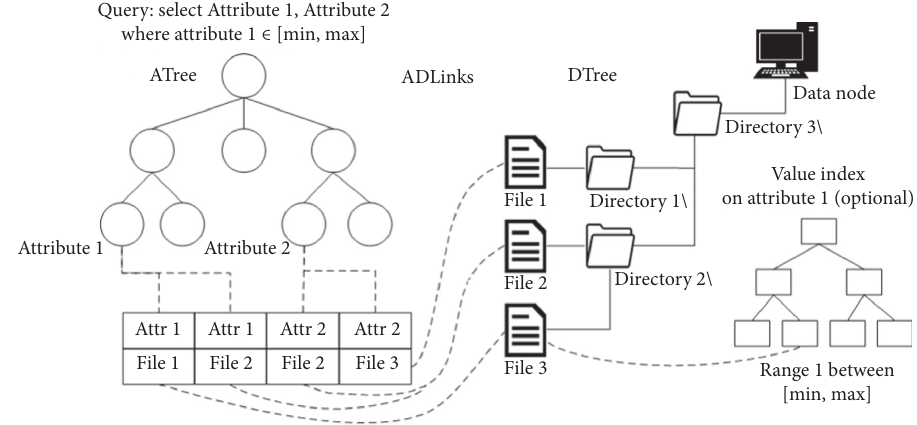
Figure 3: Structure of the attribute index.